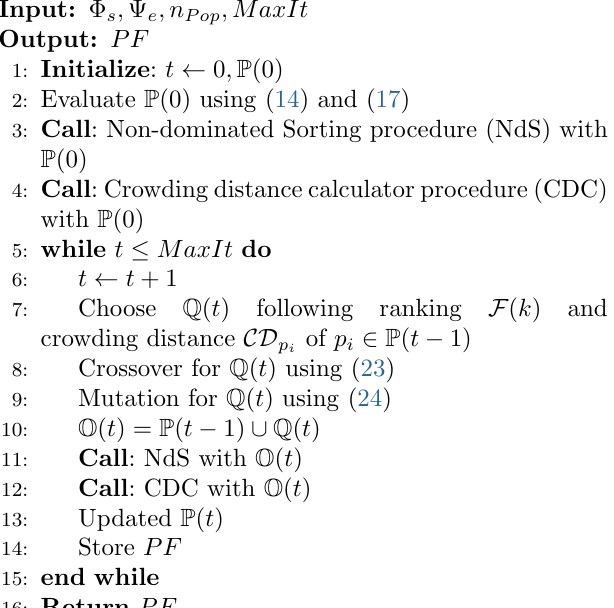
Algorithm 1 SCP and EEP maximization based on NSGA-II (SENSGA-II)